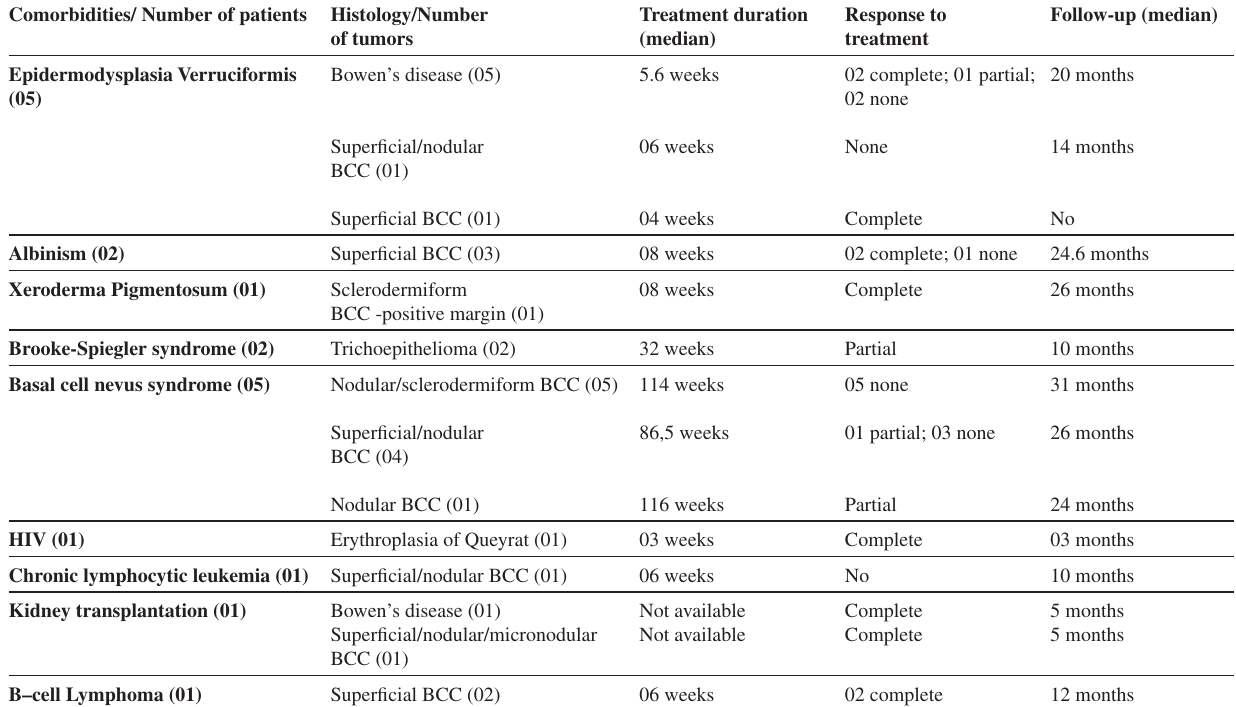
Table 1 - Usage of topical 5% imiquimod cream in patients with comorbidities Comorbidities/ Number of patients Histology/Number of